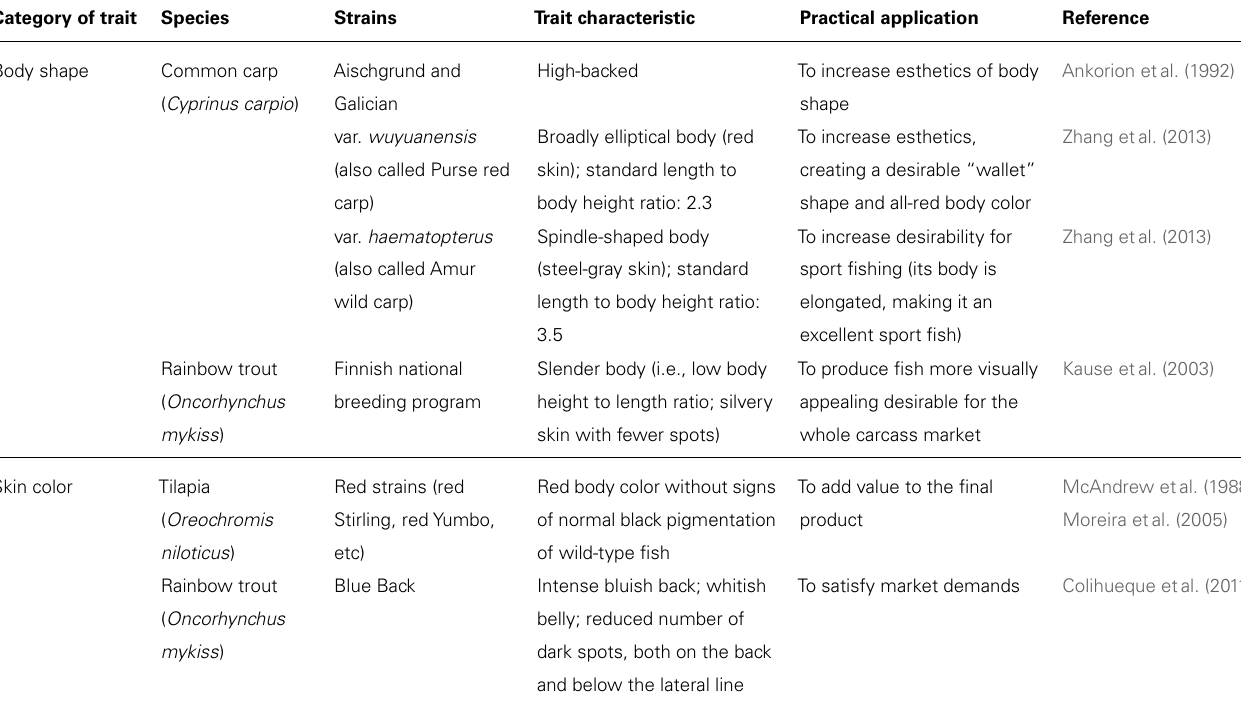
Table 1 | Examples of appearance traits for body shape and skin pigmentation used in fish farming. Category of trait